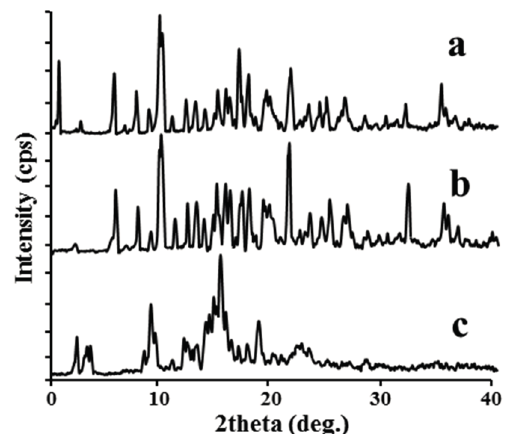
Figure 4. XRD patterns of β -CD ( a ); the physical mixture ( b ) and the inclusion complex ( c ).